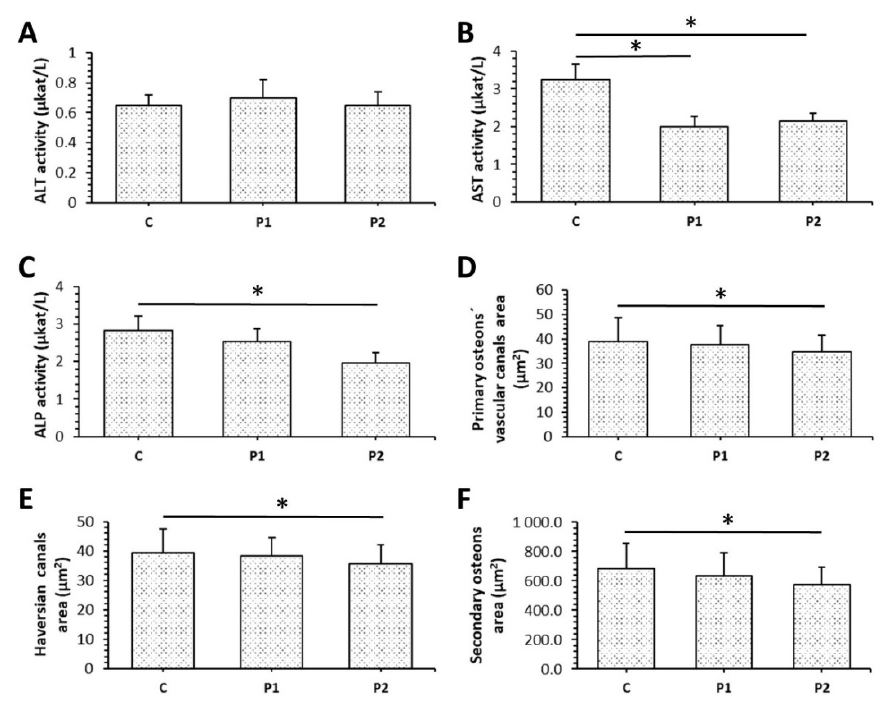
Figure 2. Levels of ALT ( A ), AST ( B ), ALP ( C ), and sizes of primary osteons’ vascular canals ( D ), Haversian canals ( E ), secondary osteons ( F ) in rats from C, P1, and P2 groups. * Significant differences ( p < 0.05).